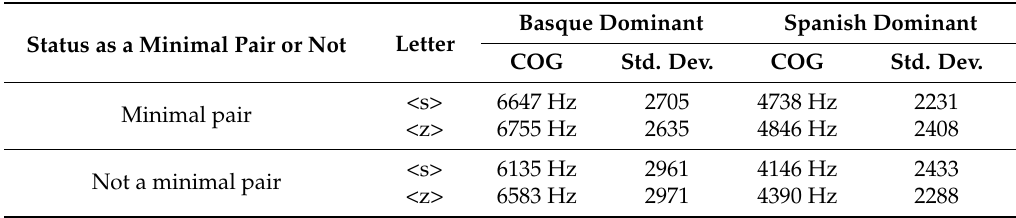
Table 9. Mean COG values in Hz and standard deviations by letter, status of the word as a minimal pair or not, and language dominance.